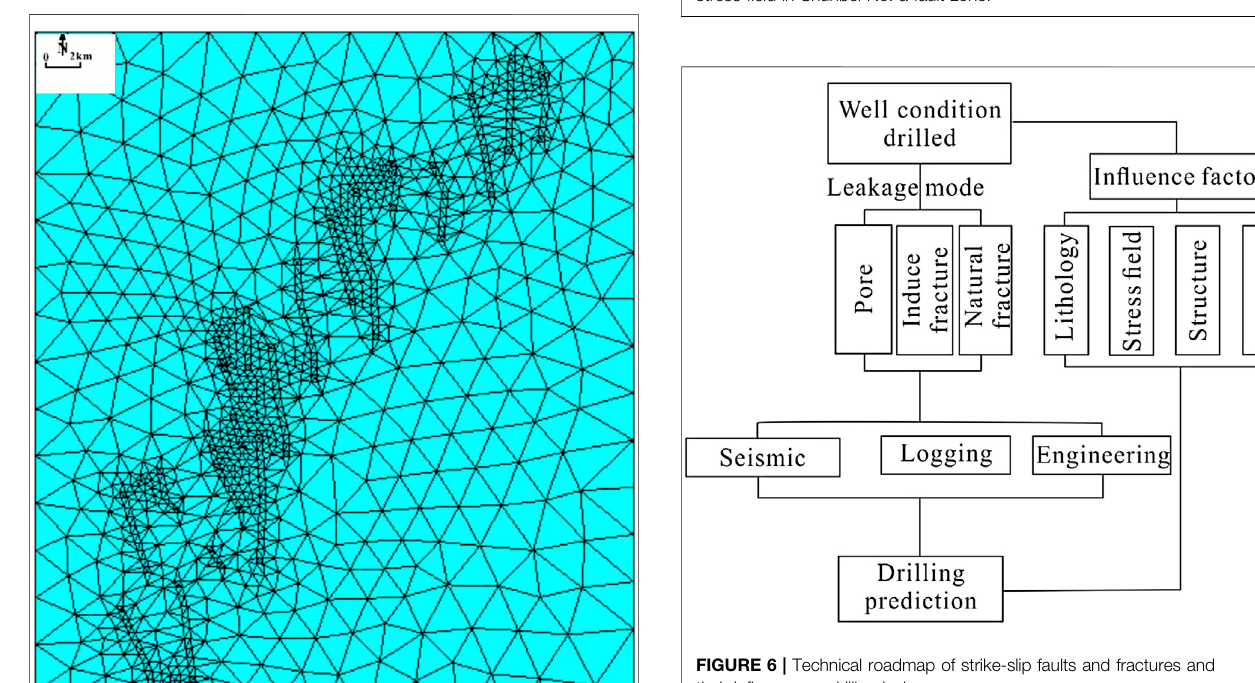
FIGURE 5 | Boundary constraints of numerical simulation of Silurian stress fi eld in Shunbei No. a fault zone.